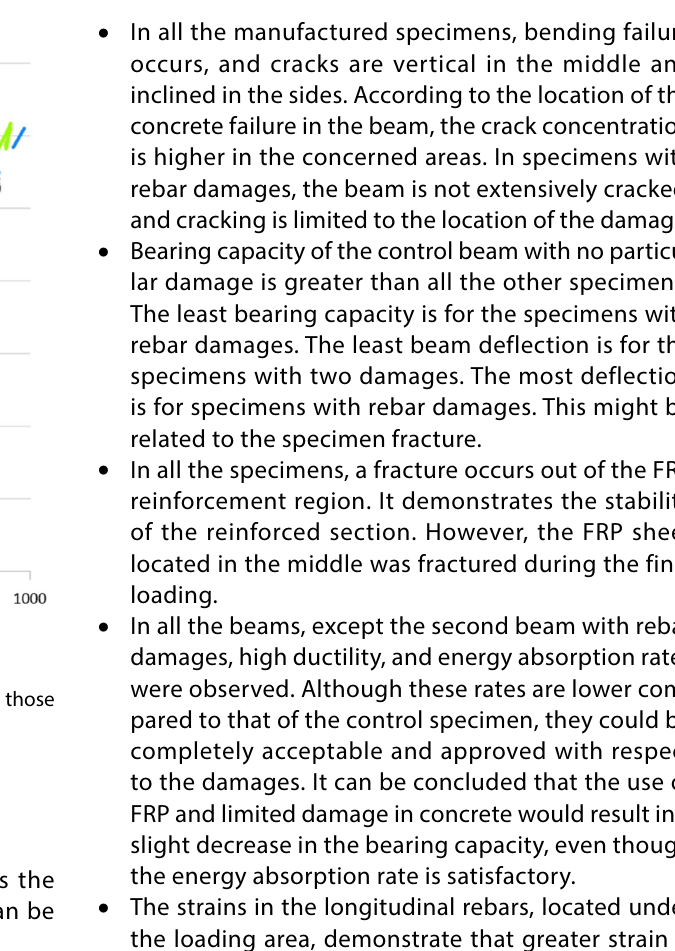
Fig. 15 Load–strain curves for two specimens compared to those of the control beam